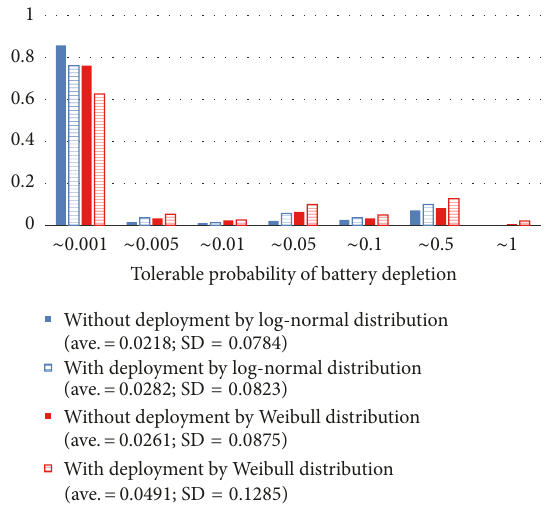
Figure 3: Distribution of the tolerable probability of battery deple-